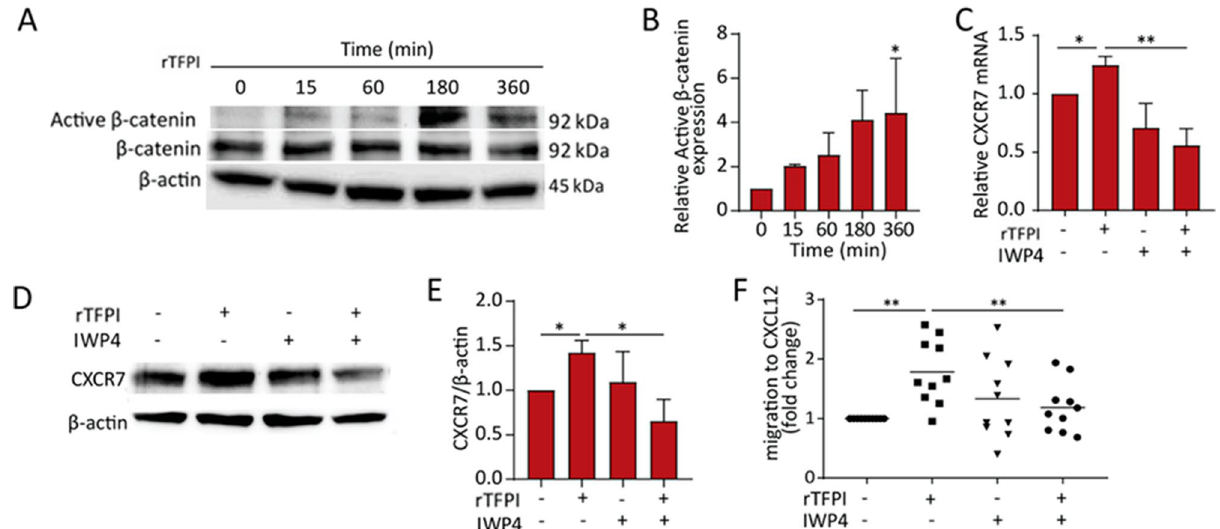
Figure 5. Activation of β-catenin is involved in the effect of TFPI on the expression of CXCR7 and the CXCL12-mediated TEM of CLL cells. ( A ) Western blotting and ( B ) quantification of the active β-catenin expression, relative to β-actin, after treating the CLL cells from patients with 200 ng/mL rTFPI for 0, 15, 60, 180 and 360 min. n = 3 individuals; *P < 0.05 ( C ) Quantitative PCR was used to detect the mRNA expression of CXCR7, relative to TBP, after CLL cells were pre-treated with IWP4 (5 µM) for 30 min prior to 24 h treatment of 200 ng/mL rTFPI, with DMSO as a control. n = 4 individuals; *P < 0.05, **P < 0.01. ( D ) Western blotting and ( E ) quantification of CXCR7 expression, relative to β-actin, after CLL cells were pre-treated with 5 µM IWP4 for 30 min prior to 24 h treatment of 200 ng/mL rTFPI, with DMSO as a control. n = 3 individuals; *P < 0.05. ( F ) CLL cells were pre-treated with 5 µM IWP4 for 30 min prior to 24 h treatment of 200 ng/mL rTFPI, with DMSO as a control. Then CLL cells were washed and applied to TEM assay. TEM results were presented as we described in Fig. 2A. n = 10 individuals; **P <